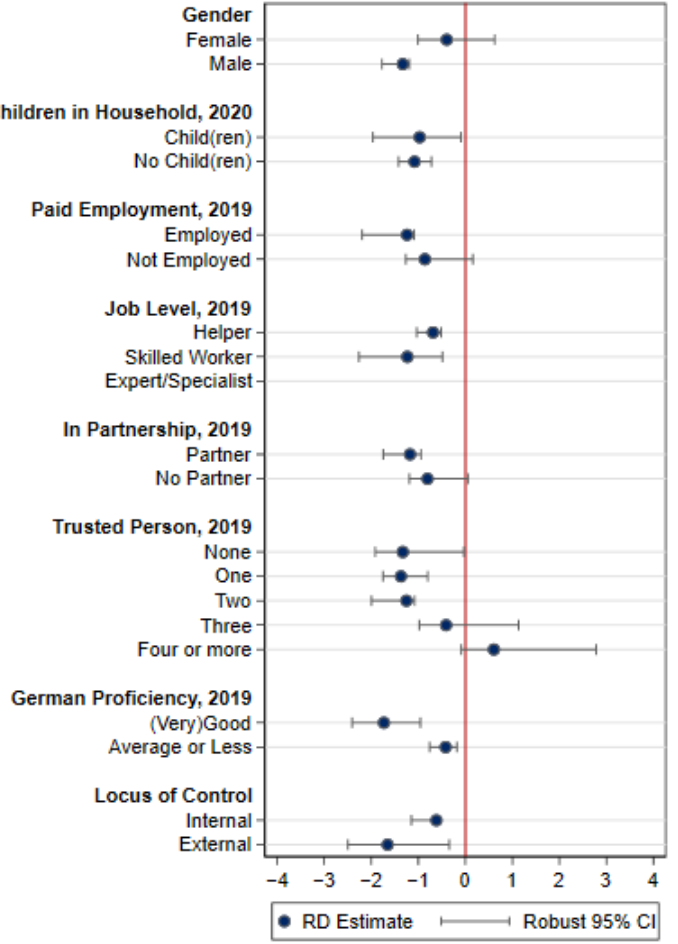
Figure 5. RD estimates by subgroups (Since for refugees employed as experts/specialists the num- ber of observations was too limited to appropriately conduct the RD analysis, we excluded the results for this subgroup from the